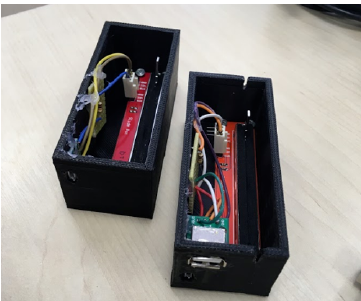
Figure 3. Linear potentiometers used to measure braking